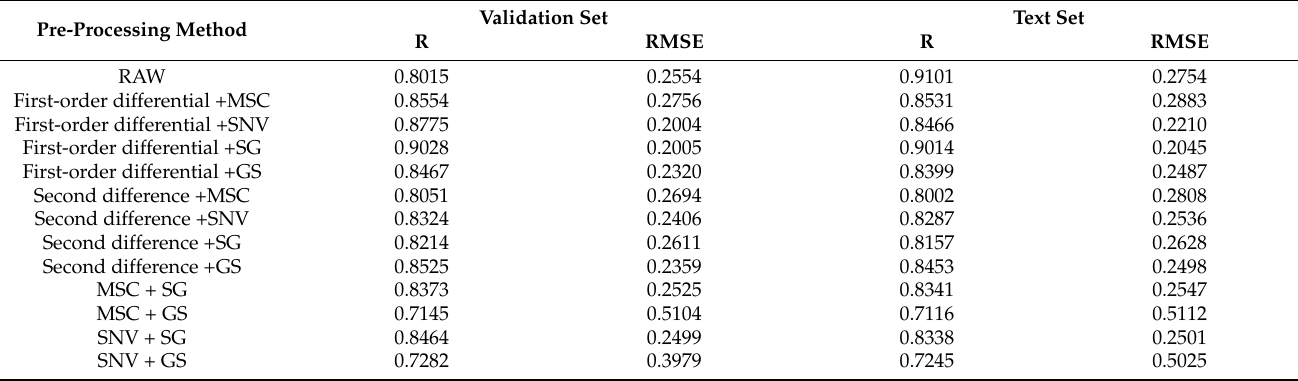
Table 2. Full-wavelength ANN prediction models for different pretreatment